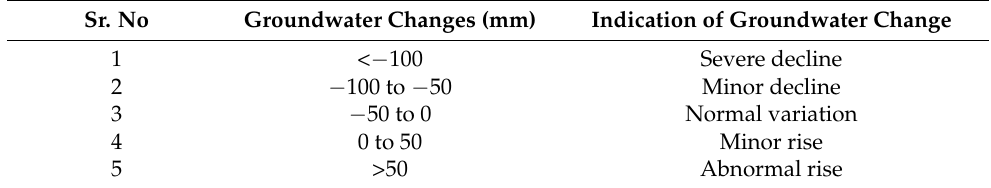
Table 1. Groundwater change categories in the Indus River Basin.